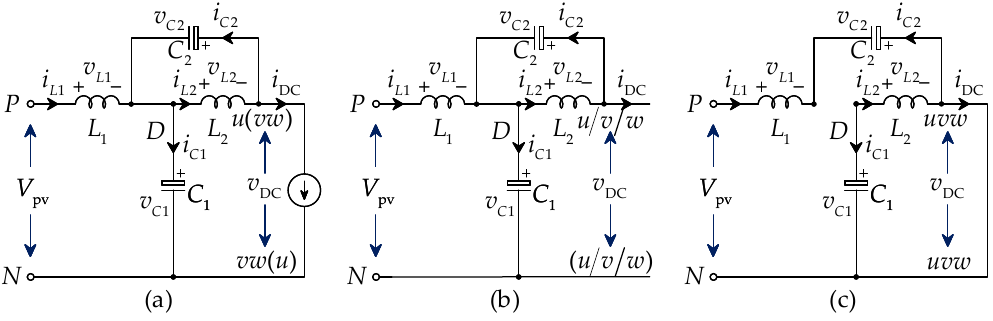
Figure 2. Equivalent circuits of the quasi-Z-source inverter during the ( a ) active state, ( b ) null state and ( c ) shoot-through state.